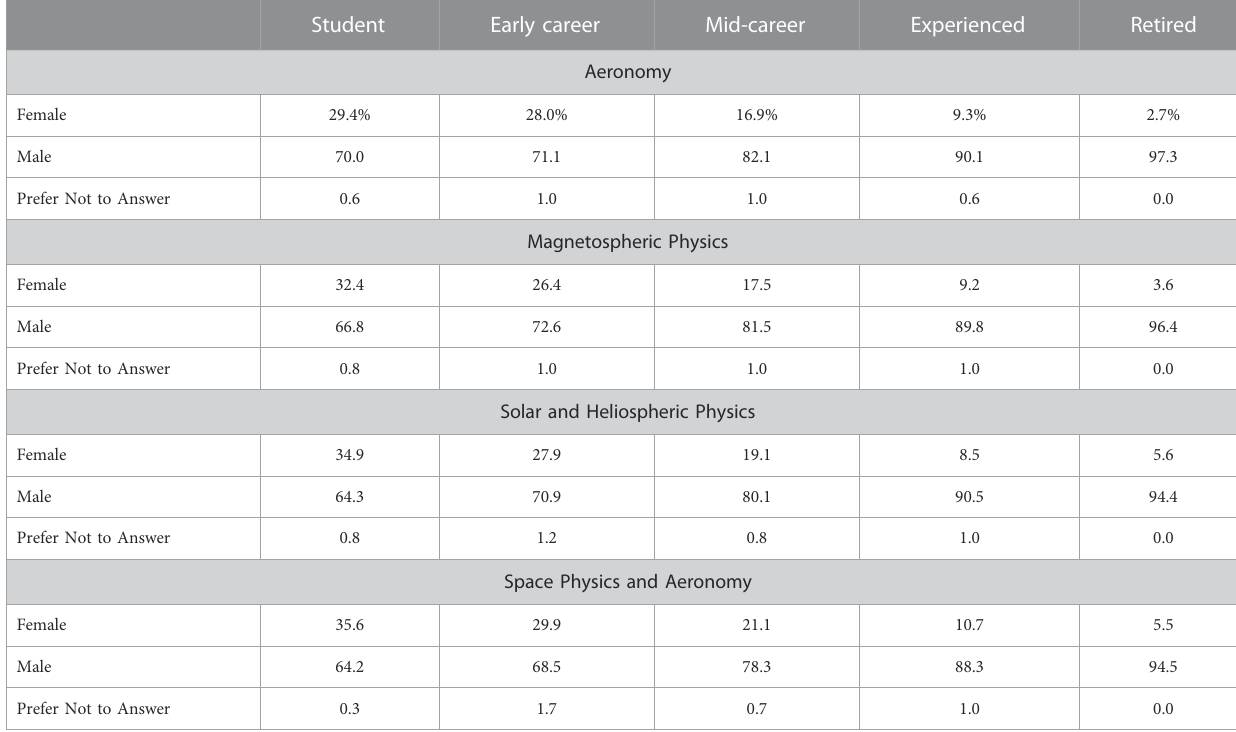
TABLE 1 AGU space physics section gender information from the 2018 membership demographics